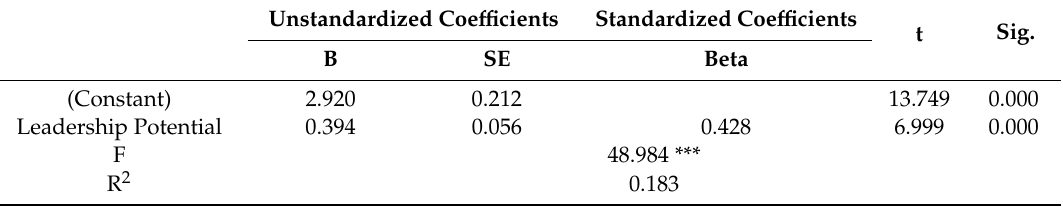
Table 6. Results for the e ff ect of leadership potential on leader’s envy ostracism.